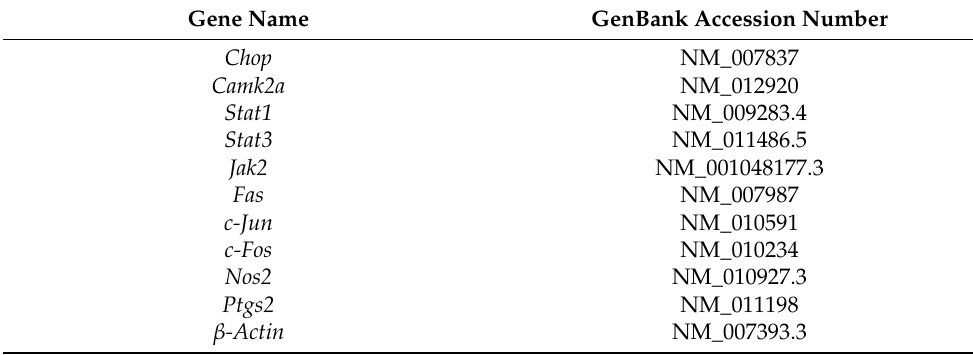
Table 1. List of GenBank accession numbers used for PCR